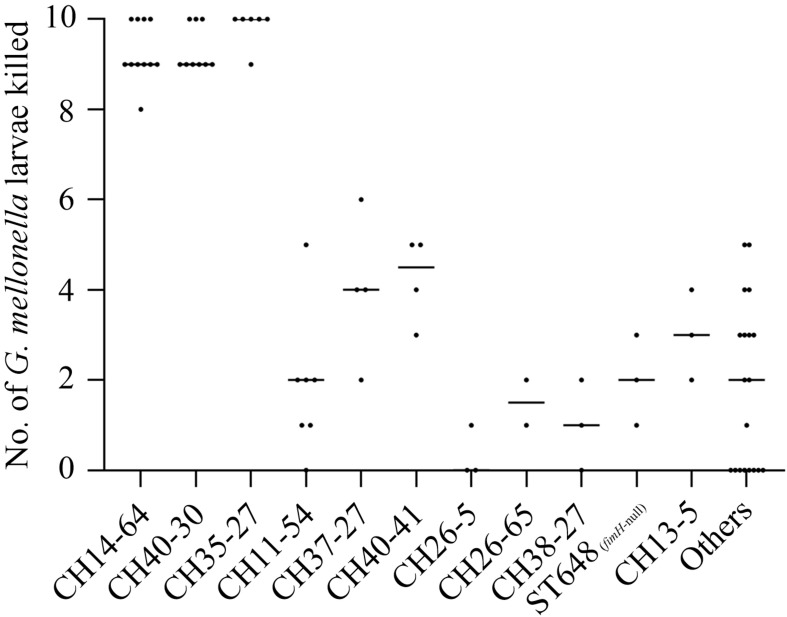
The number of larvae killed in a G. mellonella infection model according to CH or ST types among the 74 ExPEC isolates. Lethality in larvae (10 larvae/E. coli strain) was observed for 4 days after infection with test strains. Each dot corresponds to one test strain, its corresponding abscissa represents the average number of three independent experiments for the strain, and its corresponding ordinate represents the CH or ST types of the strain. Non-infected larvae and PBS challenged larvae showed no mortality. Low larvae mortality (≤20%) was recorded following challenge with E. coli DH5α. The Mann–Whitney U test showed the number of larvae killed in CH14-64, CH40-30, and CH35-27 groups were not statistically different, but higher than that in any of the remaining groups (P < 0.05).